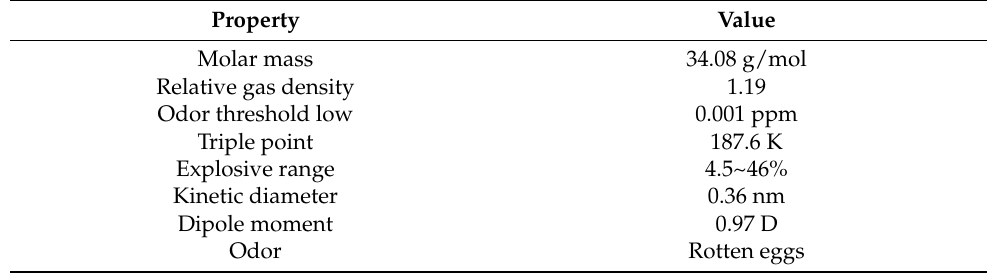
Table 1. Summary of H 2 S